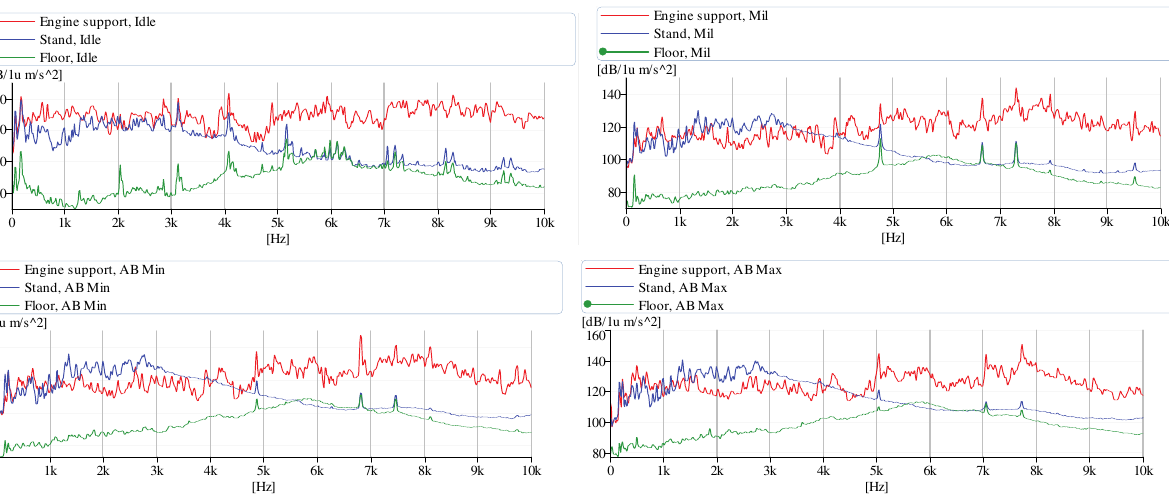
Fig. 5. The averaging amplitude spectrums of the vibration accelerations